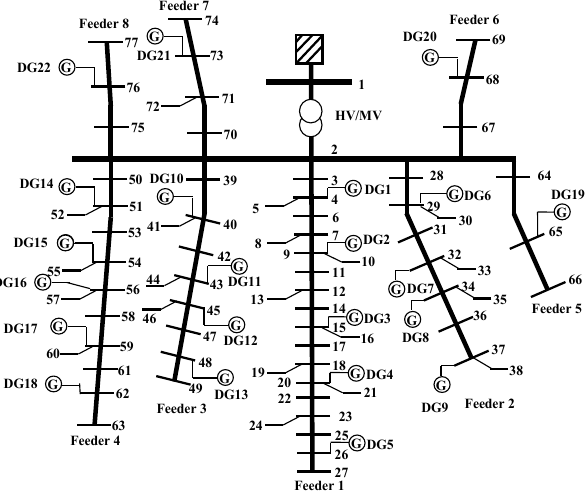
Figure 2. The 77-bus, 11 kV United Kingdom generic distribution system.